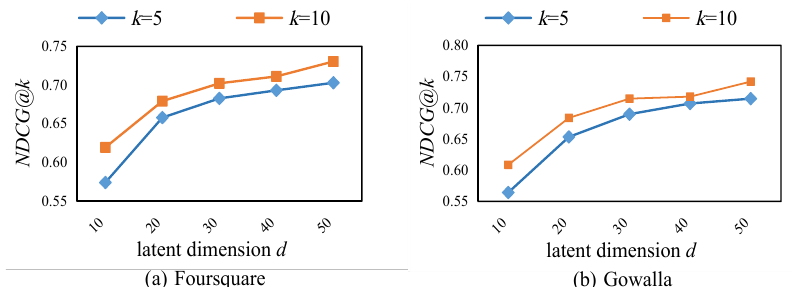
Figure 5. Effect of the latent dimension d on recommendation